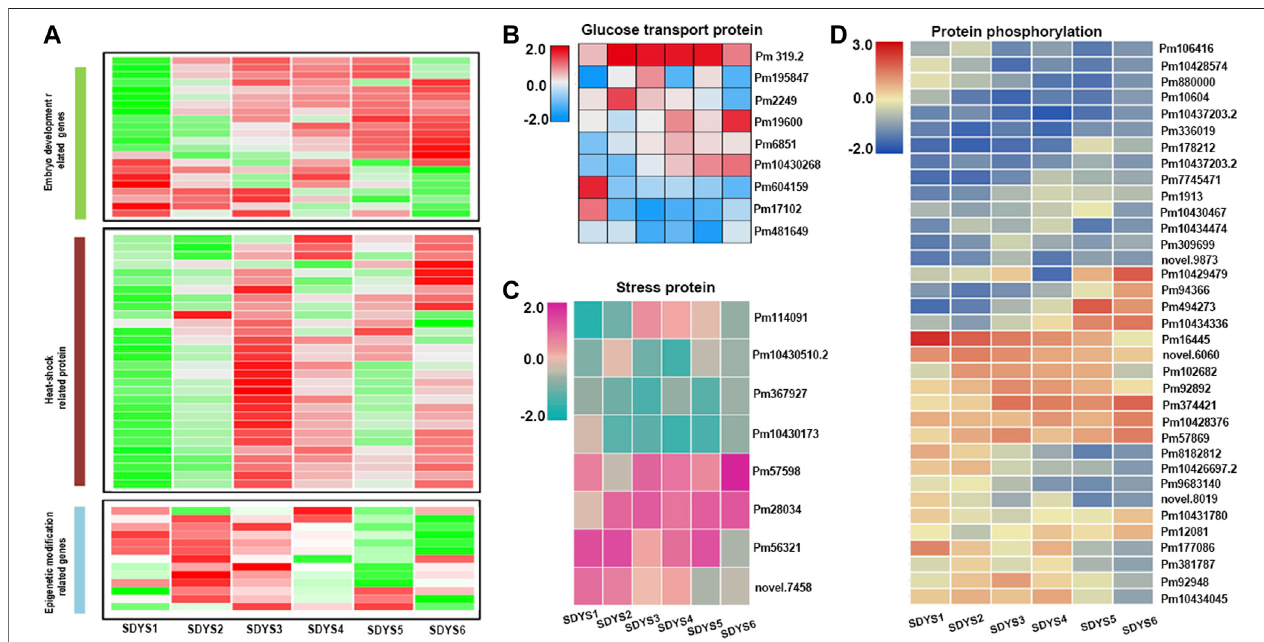
FIGURE 5 | Clustering of differentially expressed genes identi fi ed in fi ve comparisons across all six stages of embryo development. (A) Heat map of differentially expressed genes. (B) Glucose transport genes, (C) stress response genes, and (D) protein kinases and